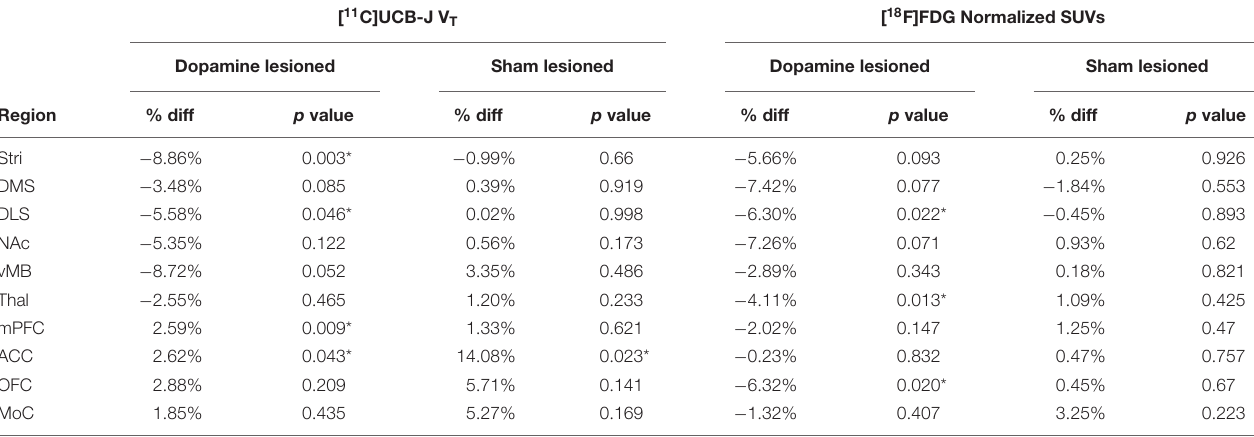
Dopamine lesioned Sham lesioned